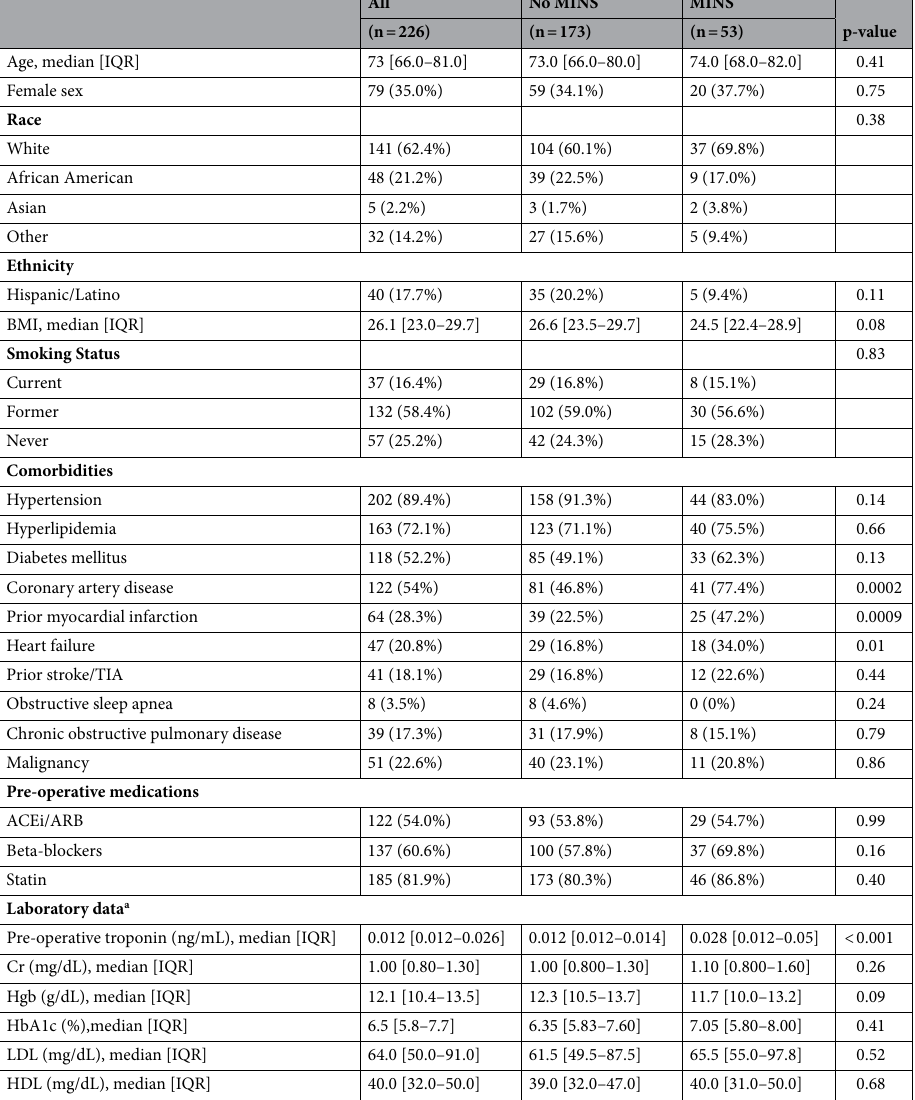
Table 1. Characteristics of patients with MINS and without MINS. a Laboratory data available in a subset of participants: Pre-operative troponin n = 143 (No MINS n = 106, MINS: n = 37). Creatinine n = 224. Hgb n = 226. HbA1c n = 124. LDL n = 84. HDL n =